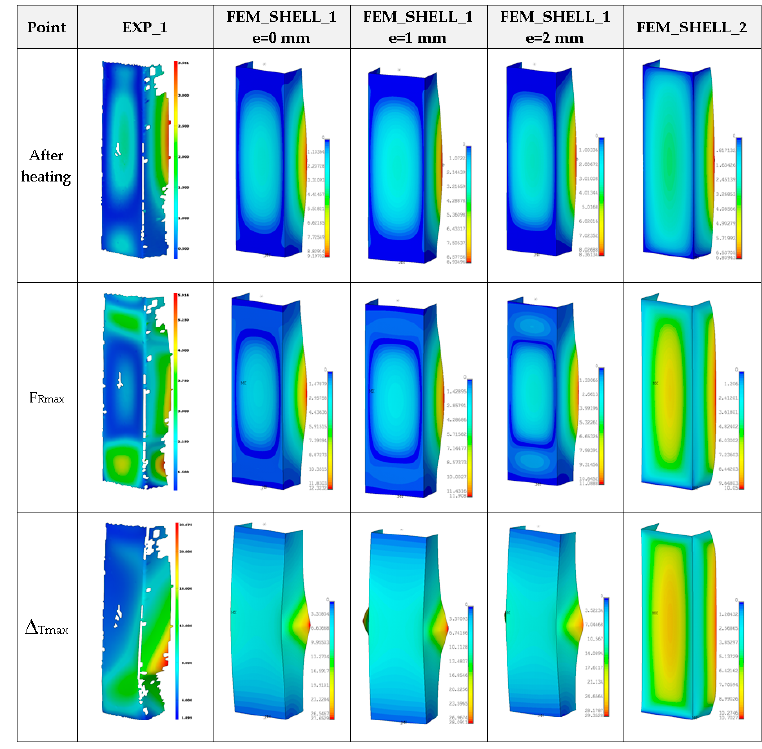
Figure 22. Deformation maps of columns at 125 °C.